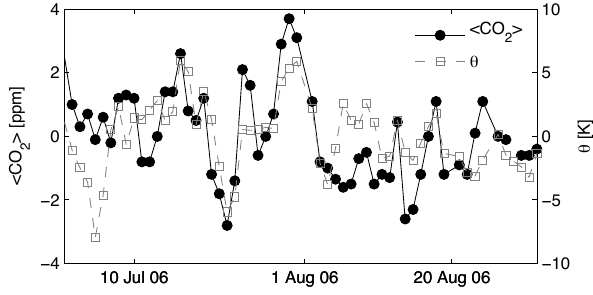
Fig. 8. Daily median h CO 2 i at Park Falls for two months in summer 2006 overlaid with daily mean potential temperature, θ , from NCEP reanalysis sampled at Park Falls at 700hPa. The mean h CO 2 i and mean θ for the two-month period have been subtracted from the re- spective time series. Within a week, daily median h CO 2 i varies by up to 5ppm. h CO 2 i and θ covary because both have strong north- south gradients and variations arise from advection of these gradi- ents.